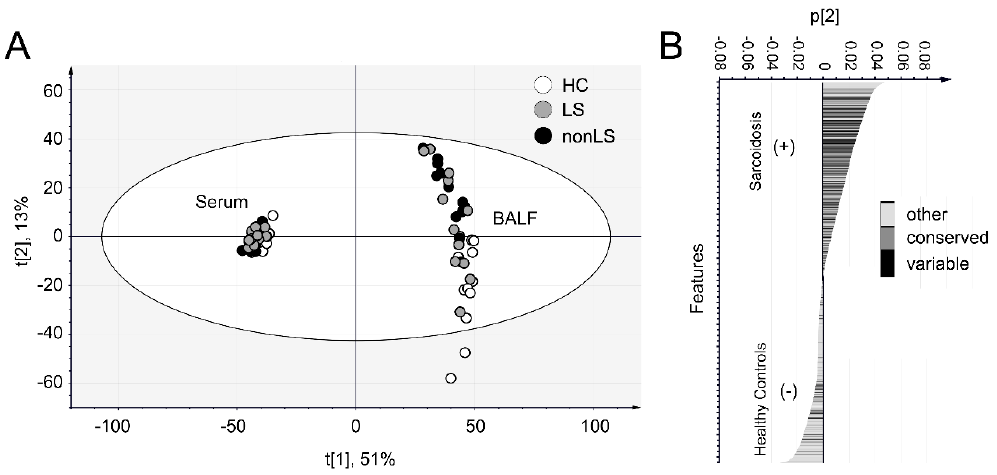
Figure 3. PCA of the complete data set including all features. ( A ) Scores plot. The profiles of the serum and BALF samples are distinctly di ff erent as observed by distinct separation along component 1 ( x -axis). The controls and sarcoidosis patients (LS and nonLS) BALF samples di ff erentiate along component 2 ( y -axis), indicating that their profiles are di ff erent according to disease. ( B ) Loading plot of component 2, i.e., the component that is disease correlating in the BALF. Note that many features that correlate with sarcoidosis are from the conserved and variable regions of